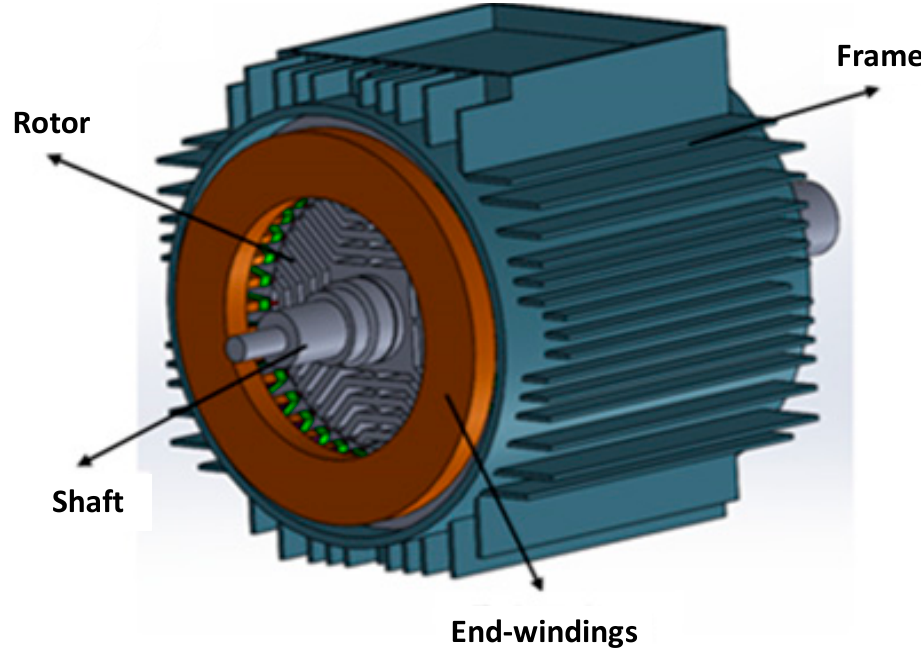
Figure 1. Structure of the transverse-laminated SynRM.